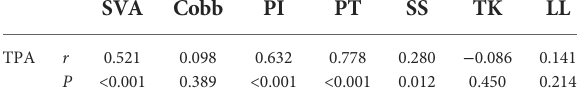
TABLE 7 Difference in anterior and posterior foot pressure load ratio between the sagittal balance and imbalance group (median and interquartile